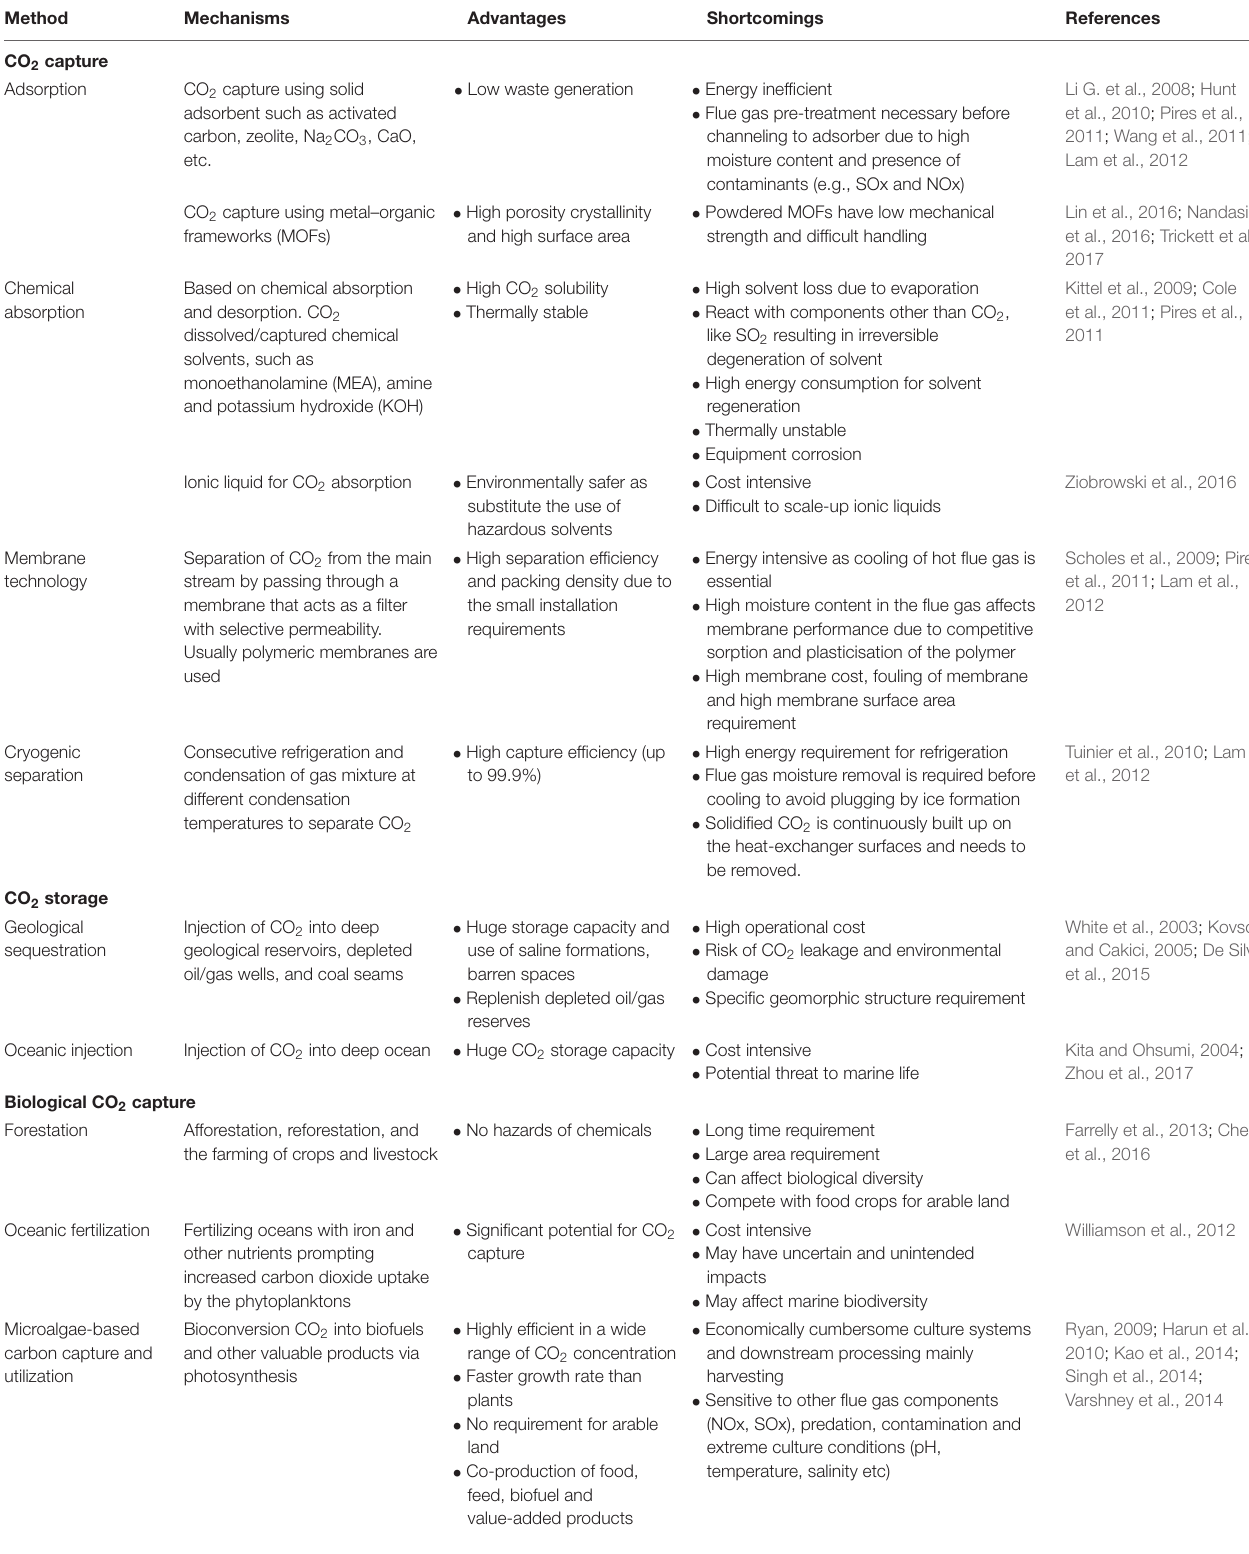
TABLE 1 | Comparative description of different carbon capture